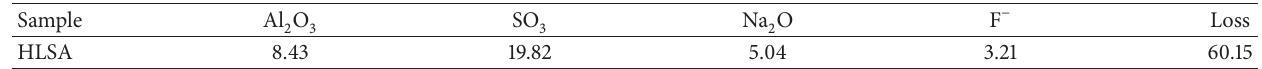
Table 2: Main chemical composition of HLSA